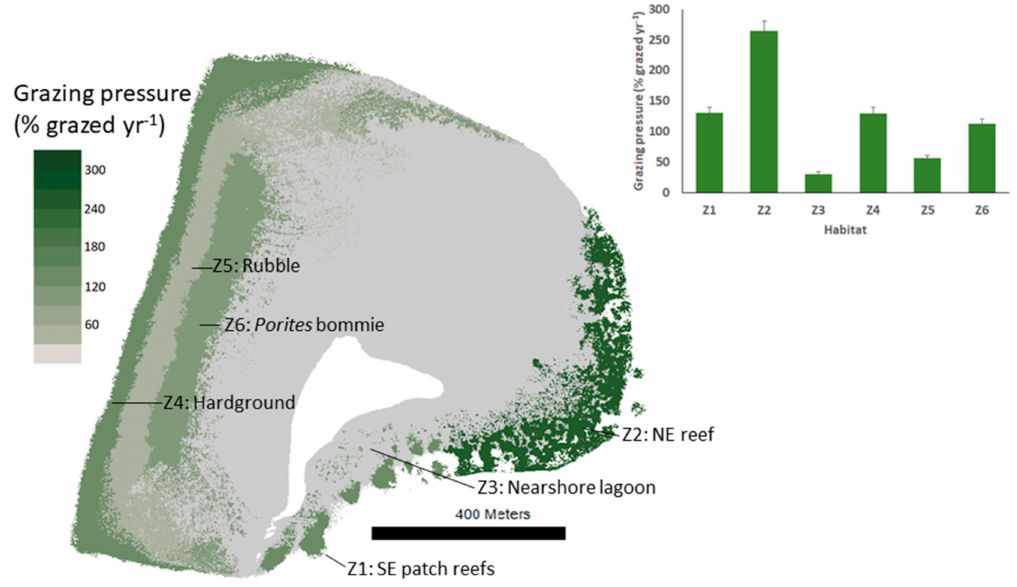
Figure 5. Choropleth map showing total parrotfish grazing pressure on the Vavvaru platform. Bar graph subplot shows grazing intensity and standard